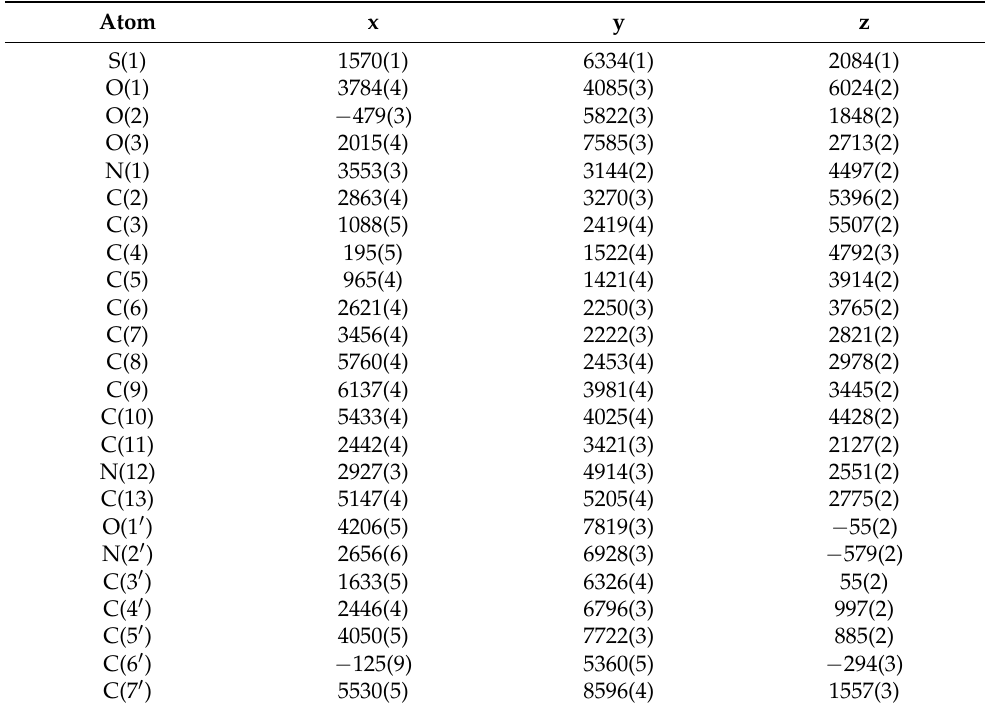
Table 4. The atomic coordinates ( × 10 4 ) of structure in cell fraction 2